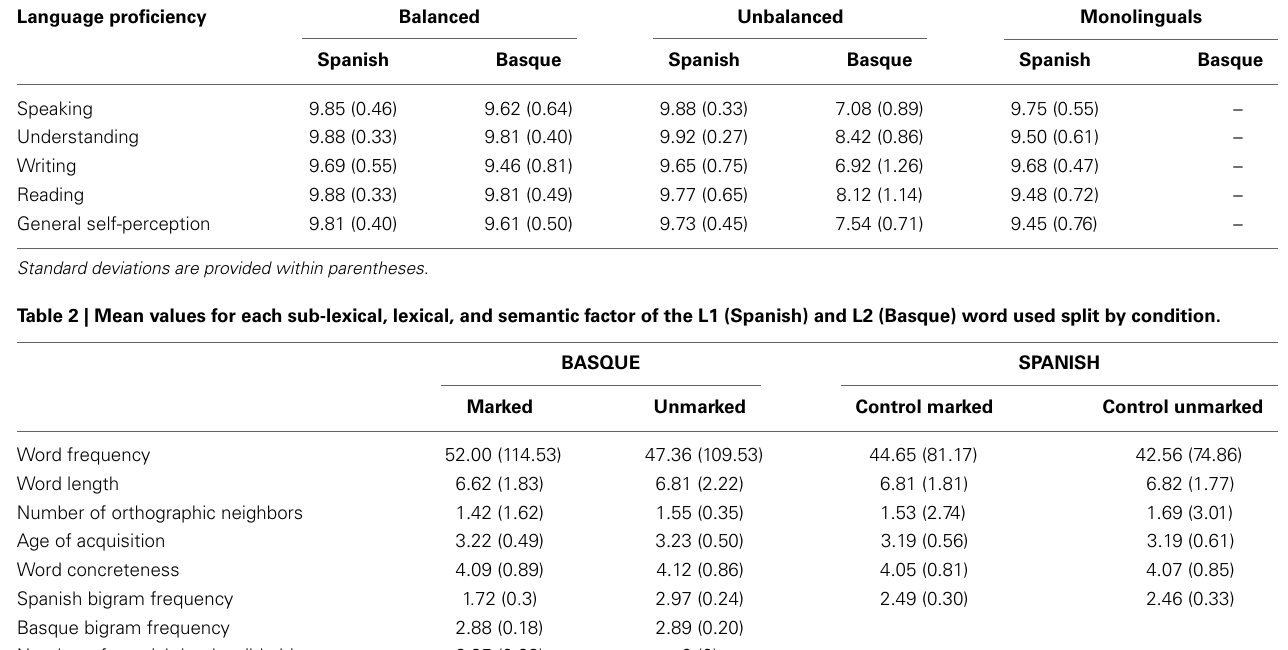
Table 1 | Mean levels of Spanish and Basque language proficiency calculated according to participants’ self-ratings (in a 1-to-10 scale).